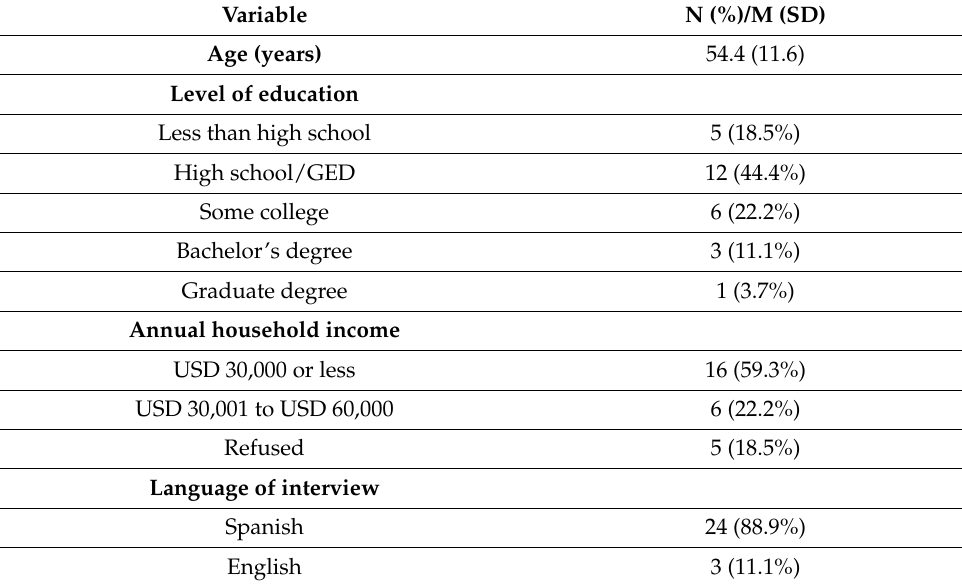
Table 1. Participants’ sociodemographic characteristics and cancer-related information (N =